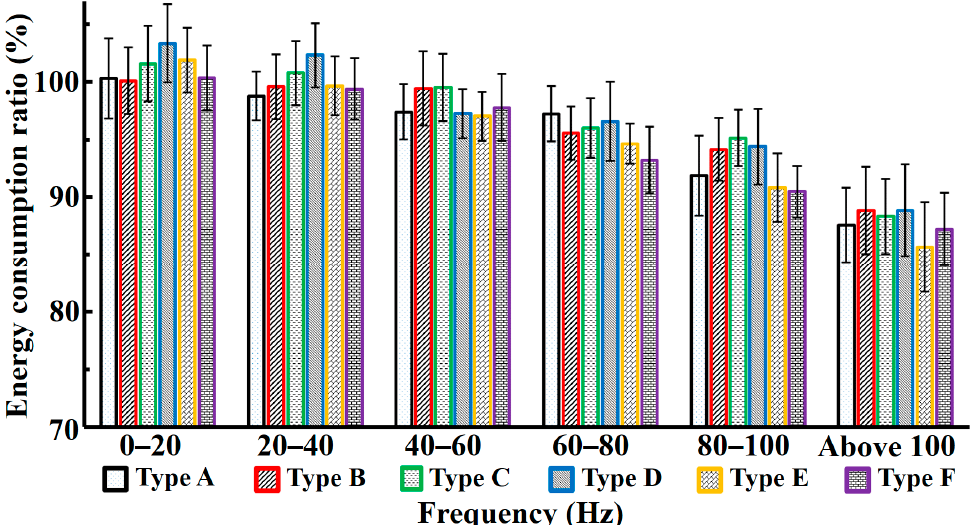
Figure 15. The ratio of forced vibration subsoiling total energy consumption to non-vibration energy consumption at 7 km/h speed.